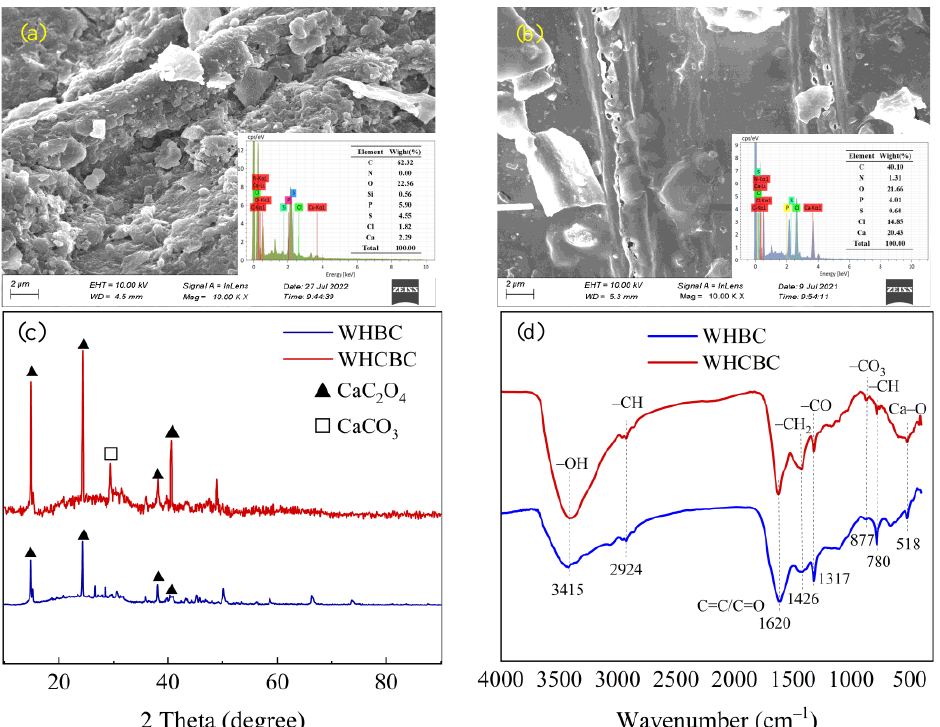
Figure 1. Characterization of WHBC and WHCBC: ( a ) SEM – EDS and element content of WHBC; ( b ) SEM – EDS and element content of WHCBC; ( c ) XRD pattern comparison of WHBC and WHCBC; ( d ) Spectral comparison of FTIR of WHBC and WHCBC.